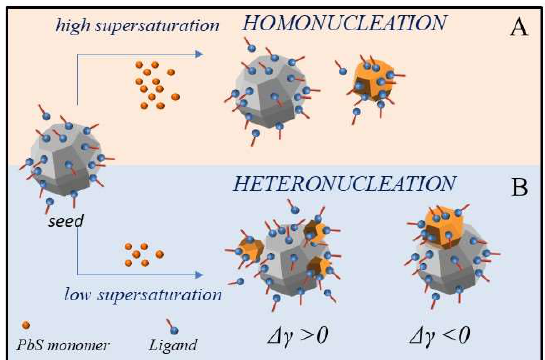
Figure 1. Seeded-growth under high ( A ) and low ( B ) supersaturation condition. Homogenous nucleation represents the upper-limit to heterogeneous nucleation. At low supersaturation, the overall interfacial energy (Δγ = γ nuclei/solution + γ i – γ seed/solution , with γ i = interfacial tension) defines the topology of the hybrid structure that, under high interfacial strain, may result in segregated phases (Δγ <0) or island-like structures (Δγ >0, Volmer-Weber growth mode). The grey dodecahedral shape NP represents the TiO 2 NC seeds while the orange structures represent the PbS